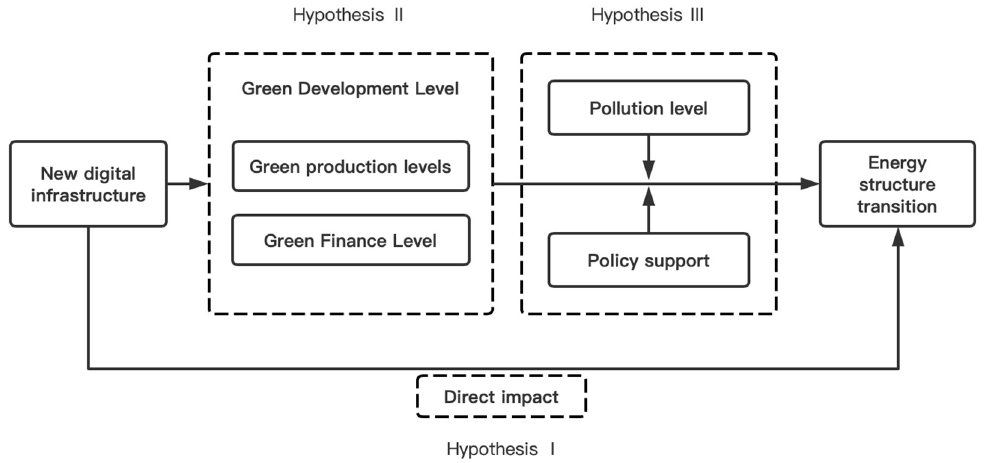
Figure 1. The impact mechanism of the NDI on energy structure transition.